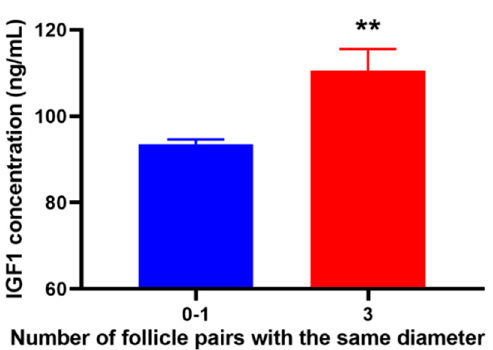
IGF1 content in the serum (Figure 6).